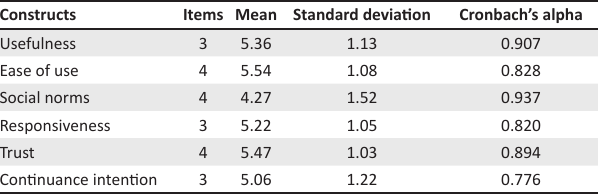
TABLE 1: Profile of the participants ( N = 293). TABLE 2: Mean, standard deviation and construct reliabilities.